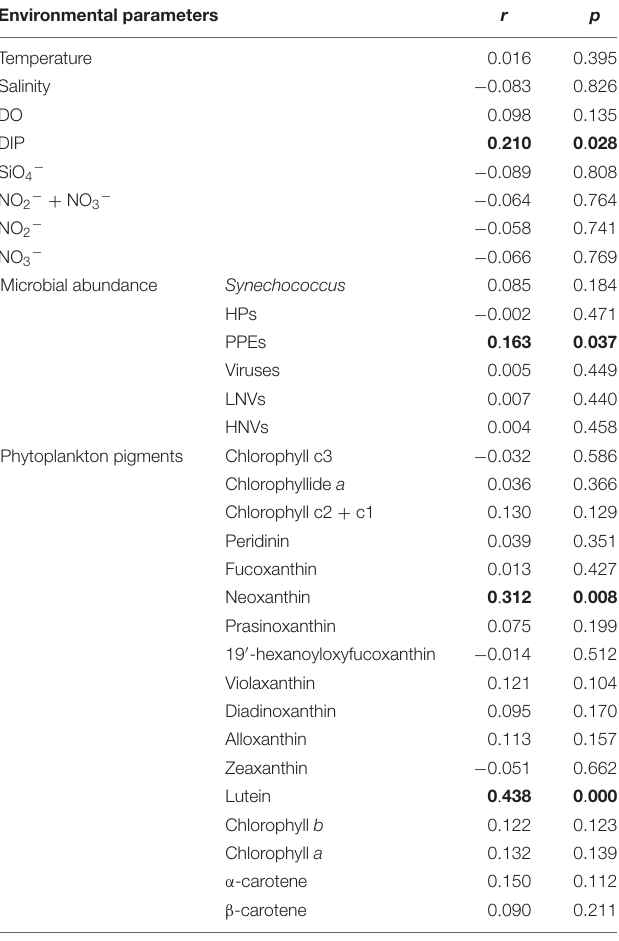
TABLE 1 | Mantel test comparison between ciliate community variability (measured as Bray–Curtis dissimilarity) and environmental parameters. Environmental